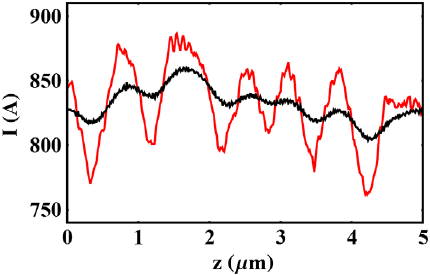
FIG. 4. Section x=z of the beam phase space observed just before the first quad of DL1 showing the longitudinal/transverse microbunching induced by the energy modulation of Fig. 3. The picture is taken where the magnitude of the 2D microbunching is the largest, see Fig. 5.